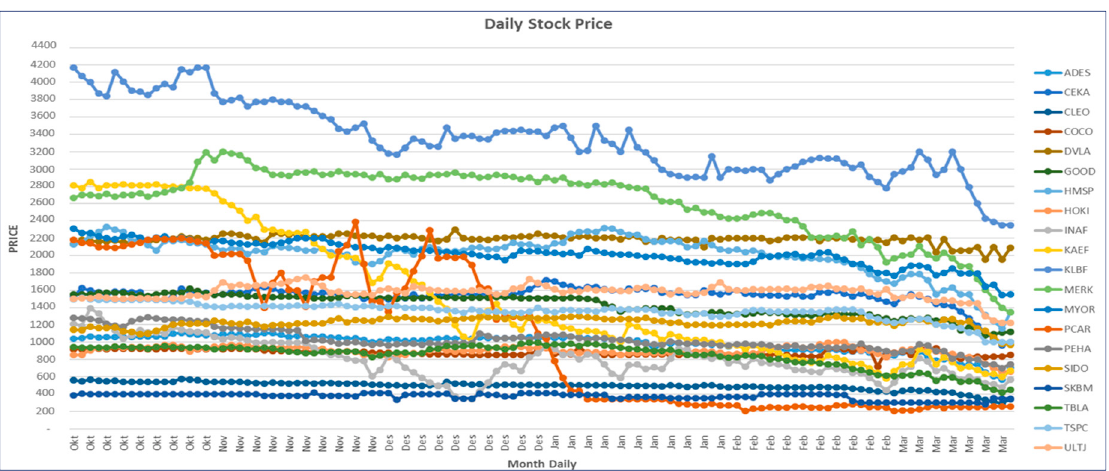
Figure 2. Daily stock price.